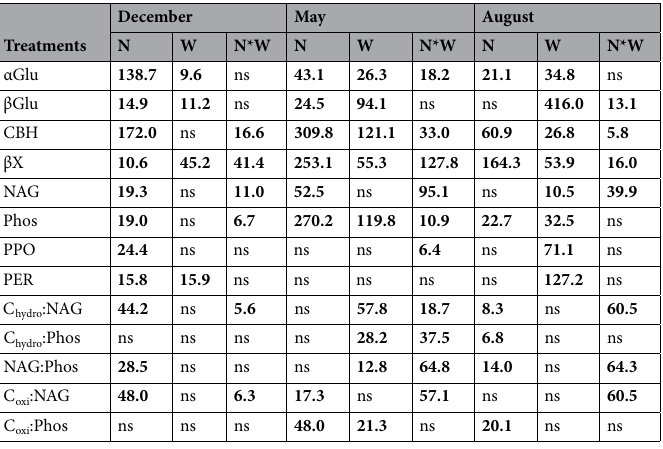
Table 2. Test of interactive effect between long-term warming (W) and nitrogen fertilization (N) on soil enzymatic activities and ratios in Decemeber, May and August. Values are F-ratios, bold indicates statistical significance at 95% confidence level (n = 18, p < 0.05).